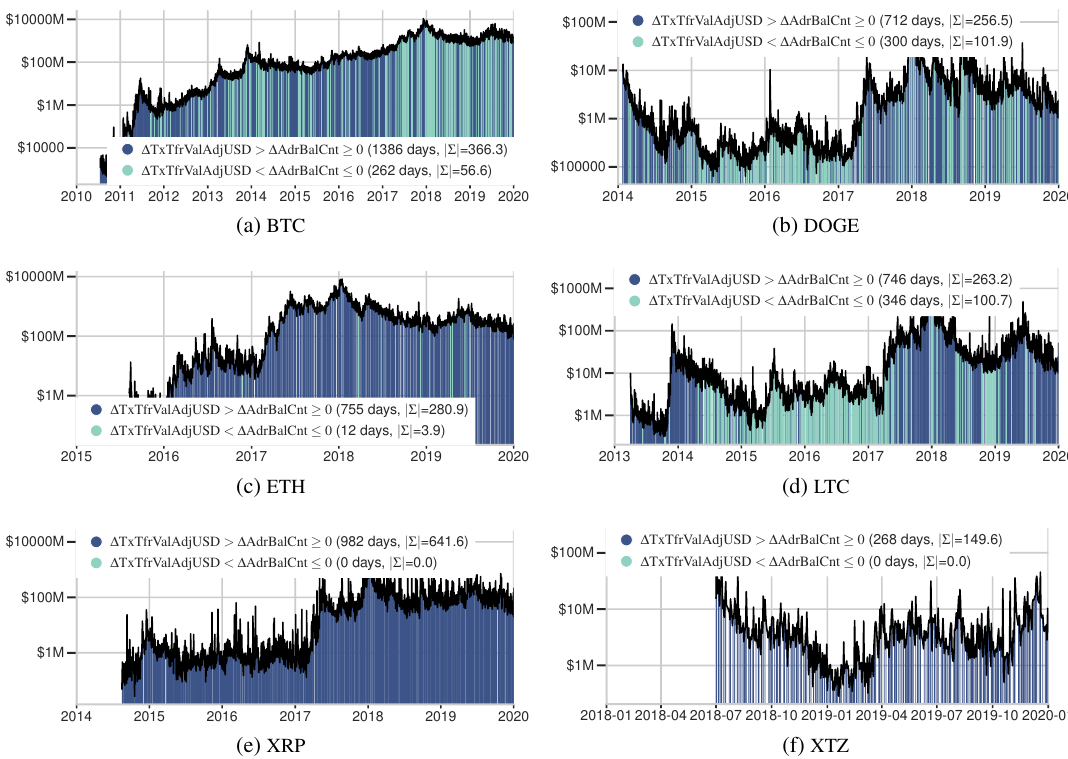
Fig. 5. Network effect observations (blue: positive NE, green: reverse NE, white: no NE); userbase measured by total addresses with non-zero balance, value measured by transaction